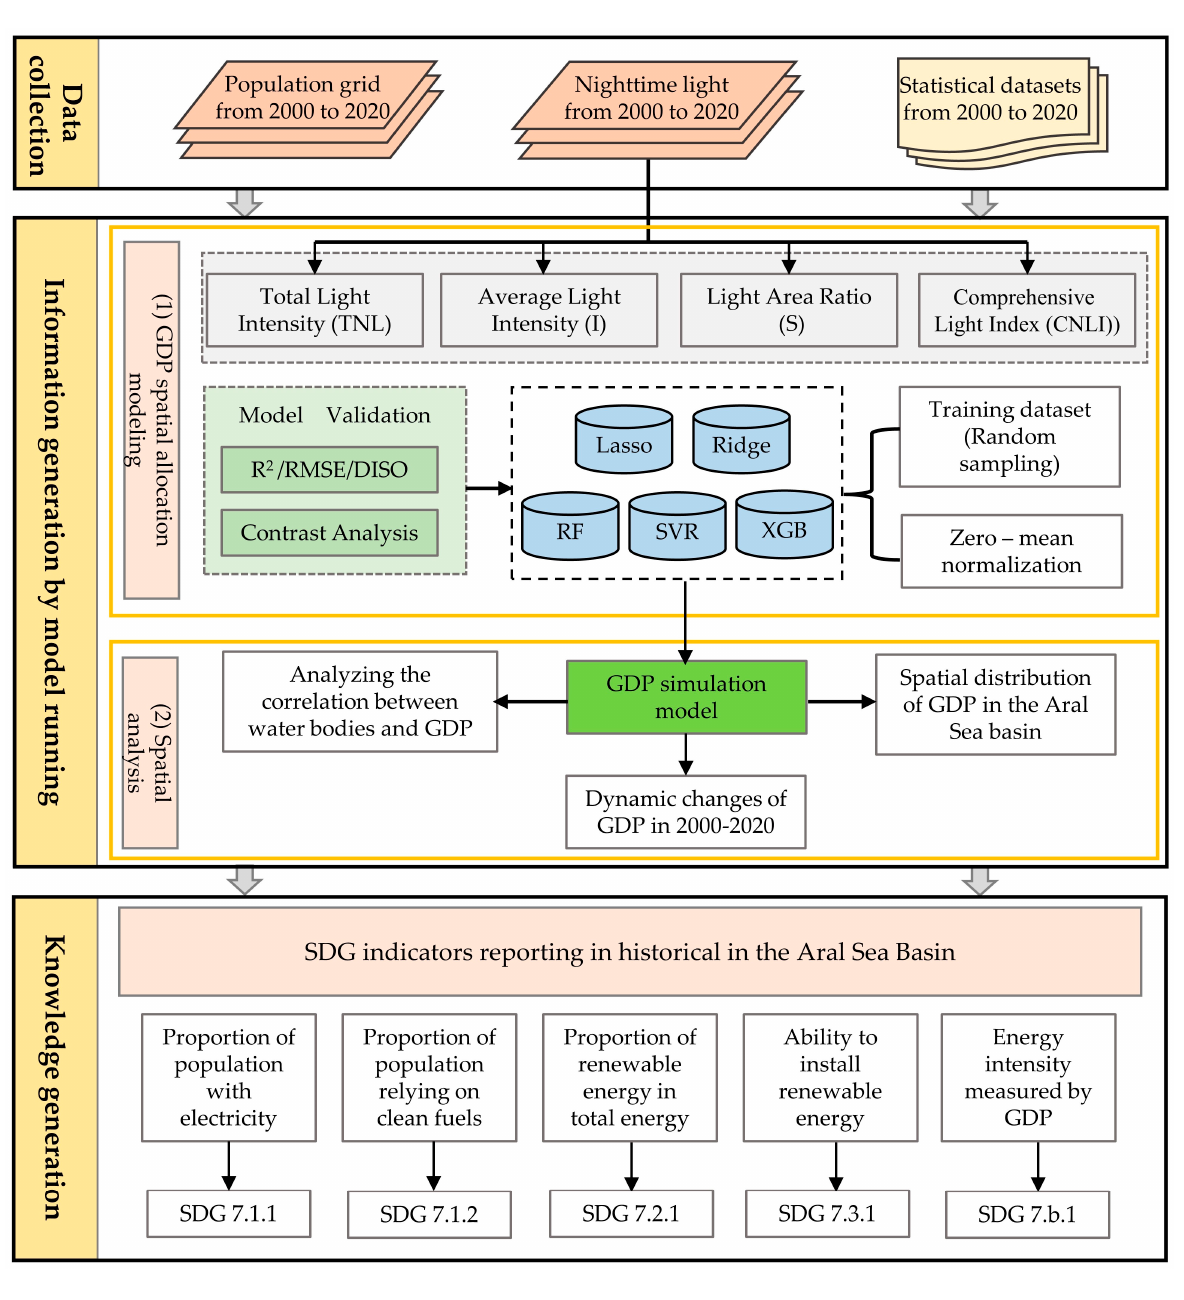
Figure 2. The framework of the SDG7 in the